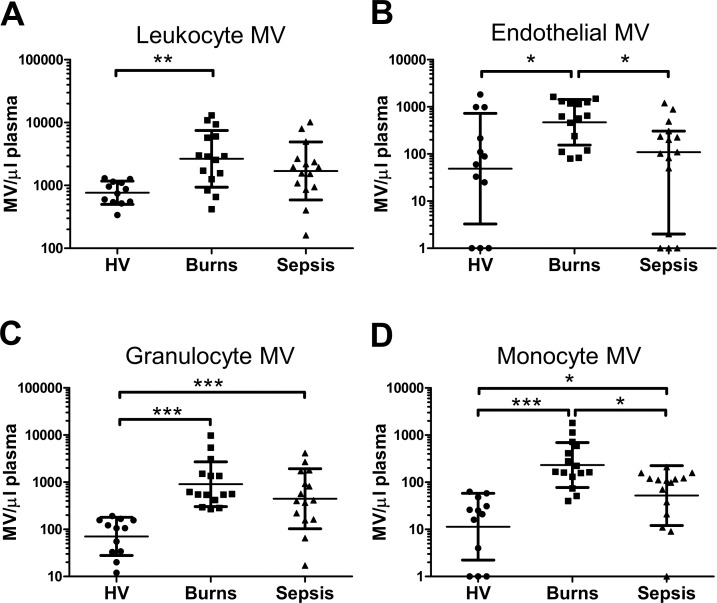
Circulating MV levels were elevated in burns patients.Plasma from healthy volunteers (HV), burns patients on day of admission, and sepsis patients was analyzed by flow cytometry to quantify MVs of different cellular origin: CD45+ leukocyte-derived (A), CD105+ endothelial-derived (B), CD66b+/CD11b+ granulocyte-derived (C), and CD45+/CD14+ monocyte-derived (D). Data are log-transformed and analyzed by one-way ANOVA with Tukey’s tests (A, C and D; mean ± SD) or Kruskal-Wallis with Dunn’s tests (B; median ± interquartile range). *p < 0.05, **p < 0.01, ***p < 0.001.